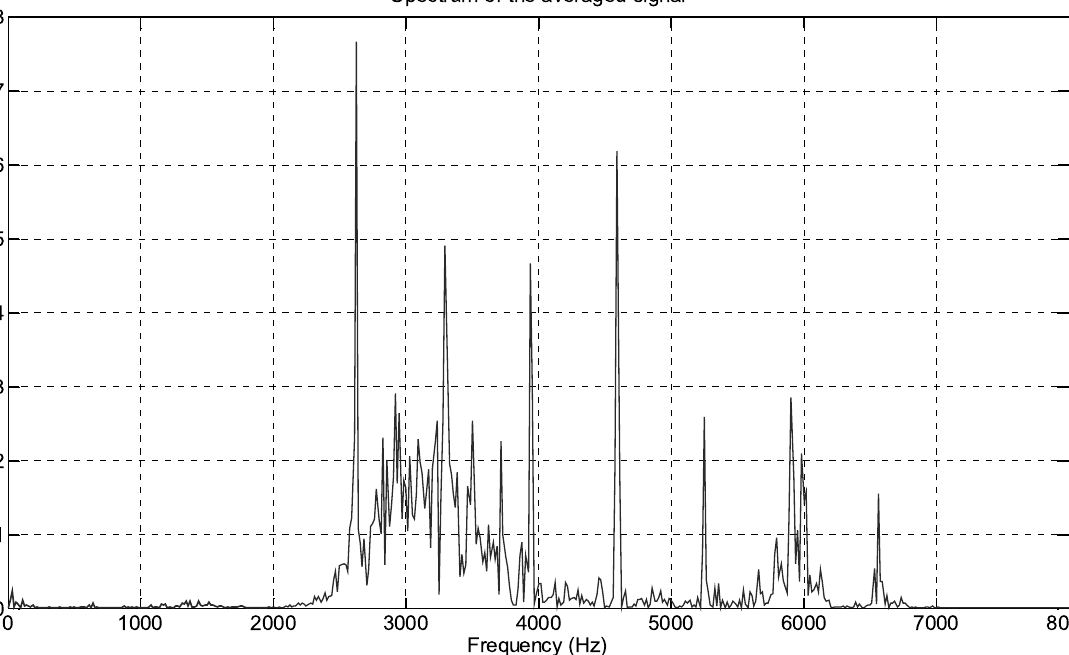
Fig. 22. Frequency spectrum of a fully broken tooth.